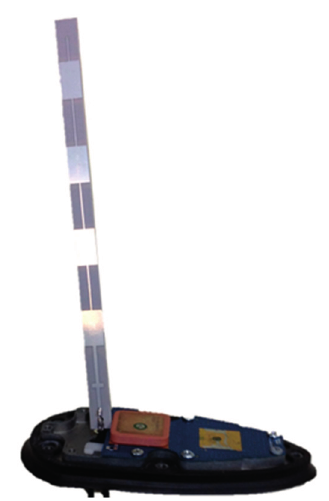
Figure 6. Proposed vehicular antennas model with GPS and